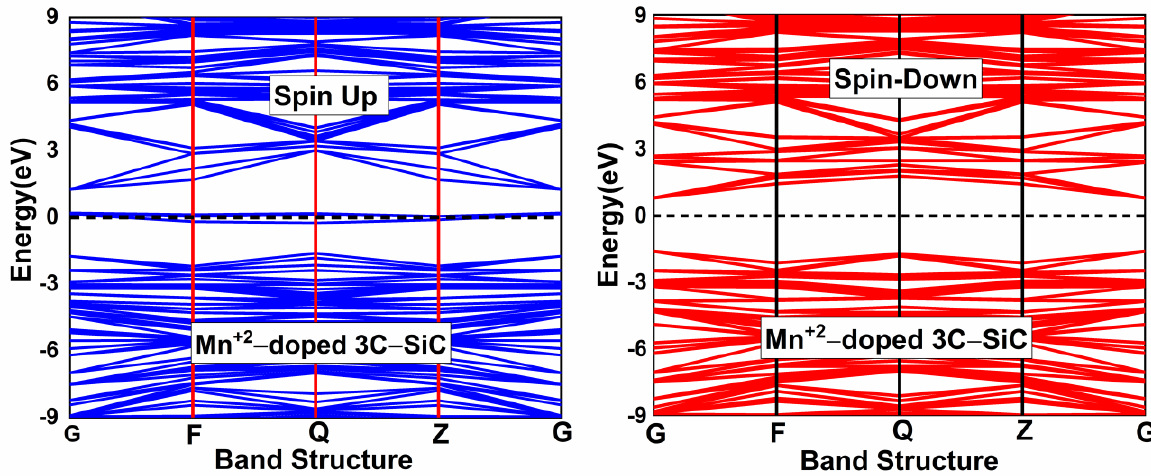
Figure 4. Spin polarized band structure of (Mn +2 )-doped 3C-SiC. Fermi level denoted by a black dash line.